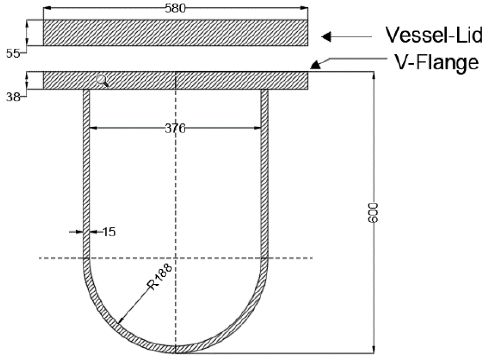
Table 1. Power law coefficients [-].